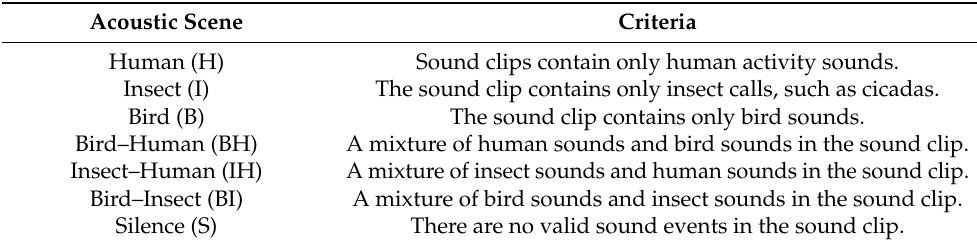
Table A1. Acoustic scene classification